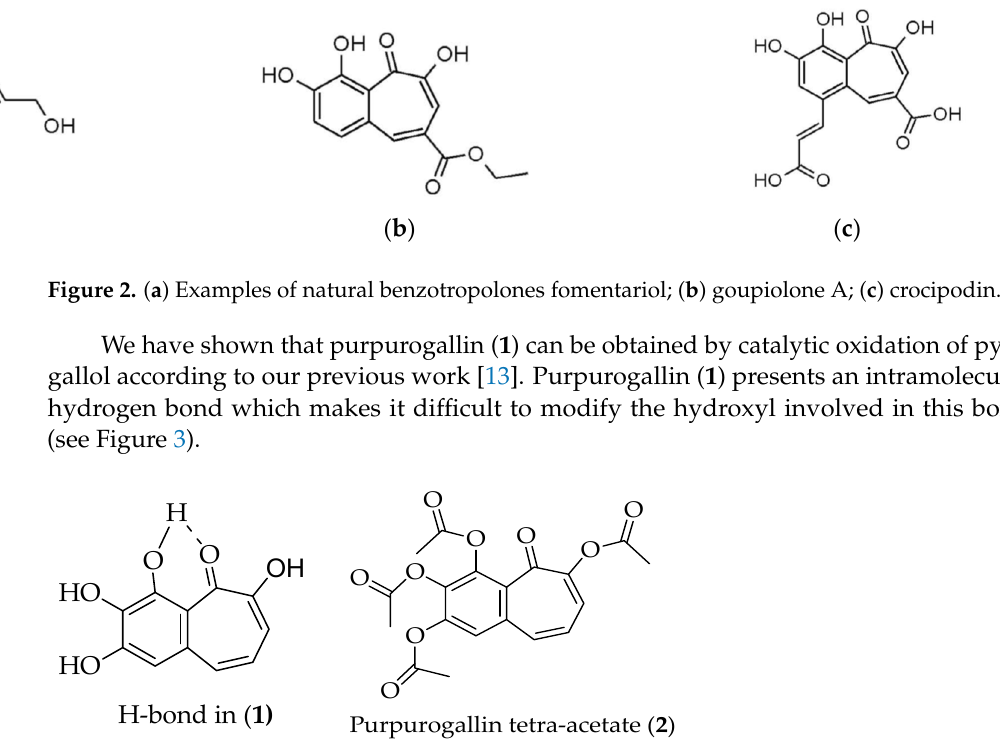
Figure 3. Intramolecular H-bond in pupurogallin ( 1 ). Purpurogallin ( 1 ) can yet be converted into purpurogallin tetraacetate by peracety- lation with acetic anhydride in the presence of DMAP [14] as catalyst in a yield of 87% according to the Scheme 1).